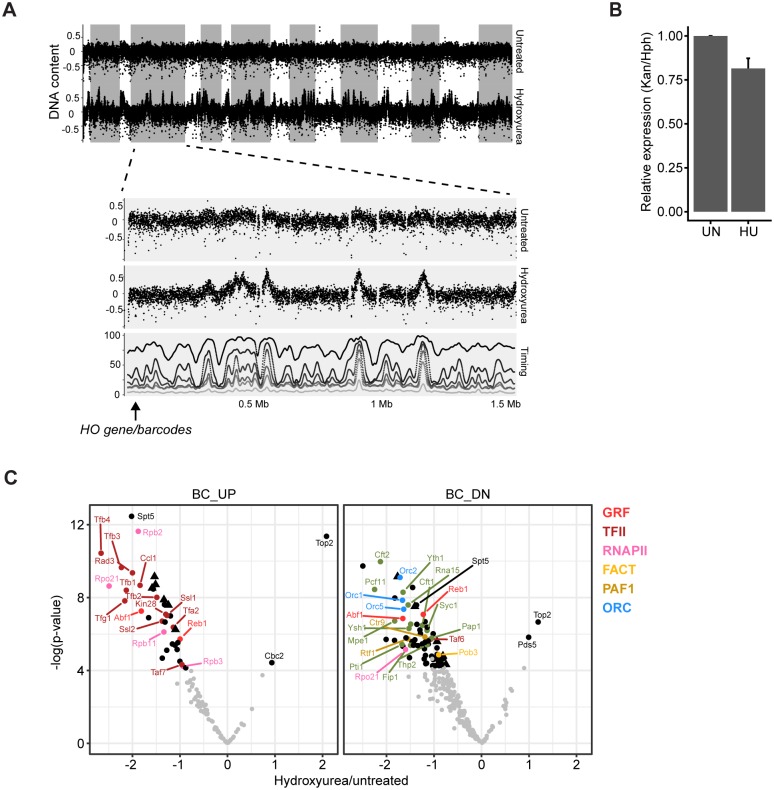
Chromatin rewiring upon HU treatment.(A) DNA regions replicated in the HU arrest were determined by DNA copy number assessment. The DNA coverage in bins of 200 bp is plotted across the genome for untreated and HU-treated samples. The lower panel shows a zoom-in of chromosome IV, which contains the barcoded locus on the left arm (indicated by the arrow). Replication timing in the absence of HU was obtained from Alvino and colleagues [36]. The percentage of replicated DNA is plotted for each bin at 10, 12.5, 15, 17.5, 25, and 40 minutes after release from a G1 arrest, as indicated by the shades of grey. (B) RT-qPCR shows relative mRNA expression of KanMX/HphMX in untreated and HU-treated samples. The untreated samples were set to 1. The average of 3 biological replicates is shown; error bars indicate SD. (C) Volcano plots showing the ratio of binding in HU-treated/untreated for factors that were significantly enriched in either one or both of the conditions. The coloured dots are factors with significantly different binding scores (FDR < 0.05). BC_DN, downstream barcode; BC_UP, upstream barcode; FDR, false discovery rate; HU, hydroxyurea; ORC, origin recognition complex; RT-qPCR, quantitative reverse transcription PCR.